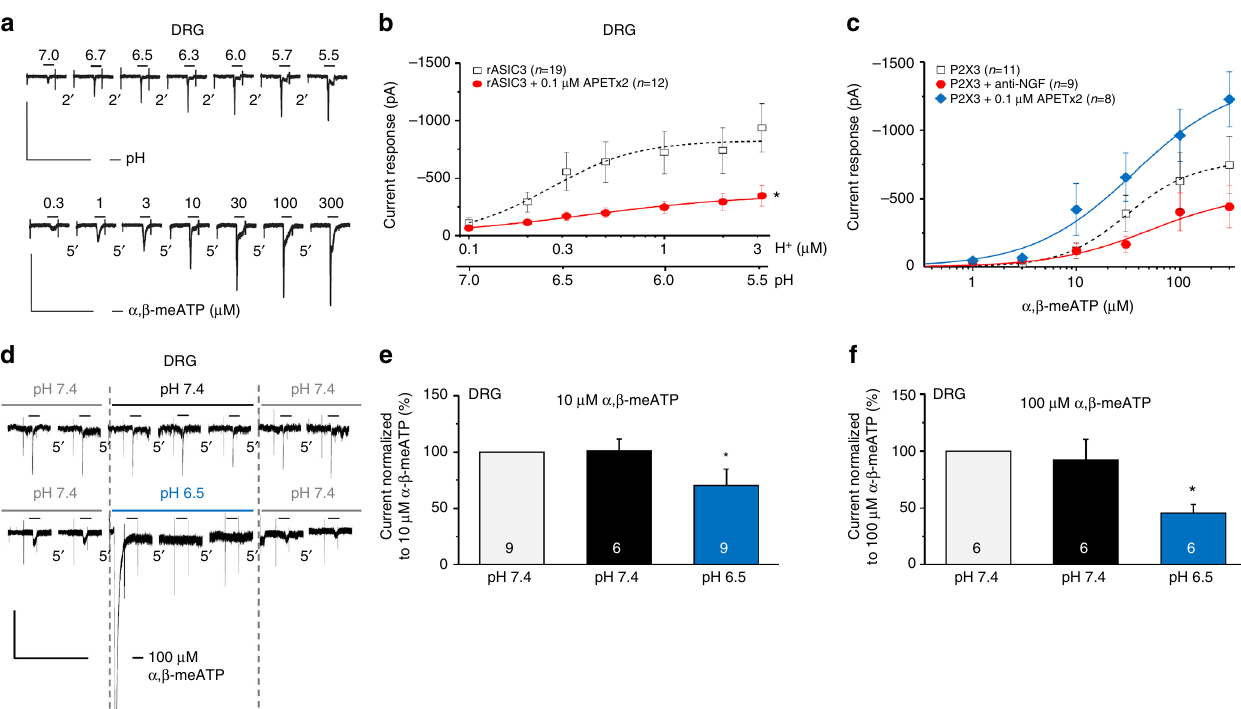
Fig. 7 Electrophysiological interaction of native ASIC3 and P2X3Rs in rat DRG neurons. Whole-cell patch-clamp recordings at a holding potential of − 65 mV. Rat cultured DRG neurons were used in all panels. Increasing concentrations of protons (pH 7.0 – 5.5) ( a , upper panel) or α , β -meATP (0.3 – 300 µ M) ( a , lower panel) were applied in the presence of 10 µ M capsazepine for 2 s with 2 min or 5 min intervals, respectively. DRG neurons were treated with APETx2 (0.1 µ M; b , c ) or anti-NGF (6 µ g/ml for 24 h; c ) while constructing concentration – response curves for protons or α , β -meATP. Means ± S.E.M. of the indicated number of experiments. * P < 0.05; statistically signi fi cant difference between the I mean values at the highest agonist concentrations (one-way ANOVA followed by the Hom – Sidak test). d Current responses were elicited by repeated applications of α , β -meATP (10 µ M) for 2 s with 5 min intervals before, during and after the pH shift from 7.4 to 6.5; representative tracings. The peak of the proton-induced current was retouched in the lower panel of ( d ). Percentage changes of α , β -meATP-induced current responses at 10 µ M ( e ) or 100 µ M ( f ) were calculated with respect to the second current amplitude before the pH shift from 7.4 to 6.5. Means ± S.E.M. of the indicated number of experiments. * P < 0.05; statistically signi fi cant difference between the current amplitudes before and after the pH shift from 7.4 to 6.5 (one-way ANOVA followed by the Bonferroni test). The scale labels for the vertical bars were 500 pA ( a ) and 200 pA ( b ). The scale labels for the horizontal bars were 20 s ( a ) and 50 s ( d (Fig. 7a, lower panel). The amplitudes of the current responses to α , β -meATP were not altered either after the application of APETx2 (0.1 µM) or after incubation with anti-nerve growth factor antibody (anti-NGF, 6 µg/ml for 24 h) (Fig. 7c). None-